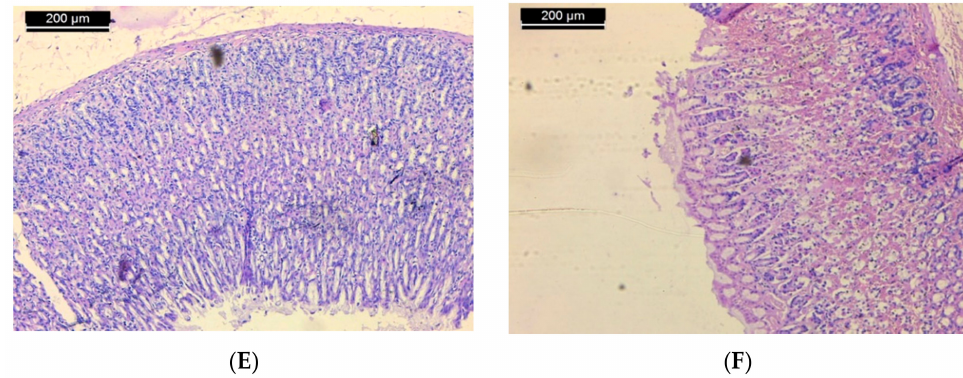
Figure 2. Micrograph of sections of the stomach of rats from ( A ): normal control shows mucosa with intact surface mucosal epithelium and no lesion appeared; ( B ): ulcerated group shows severe disruption of the surface epithelium and necrotic lesions mucosa with hemorrhagic erosion, ( C ): the group treated with 50 mg/kg of ST-1 shows mucosa appeared more like the control ( D ): the group treated with 50 mg/kg of ST-1 shows mild mucosal surface erosion and no edema; ( E ): the group treated with 100 mg/kg of ST-1 shows intact surface mucosal epithelium and no lesions which have appeared; ( F ): the group treated with ranitidine, showing mild erosion of mucosa (H & E stain, Scale Bar; 200 µ